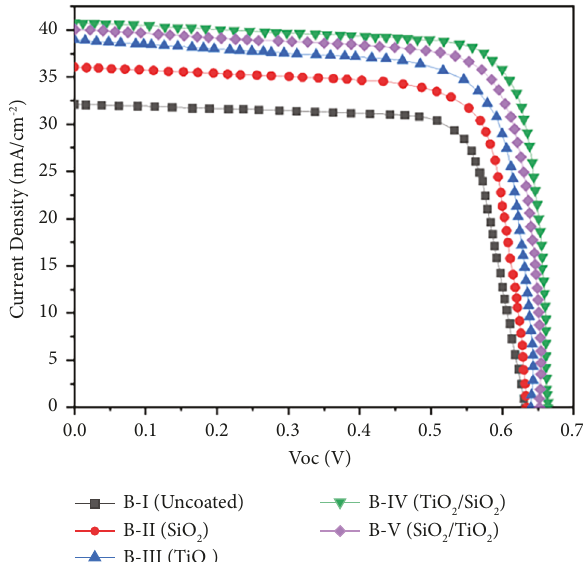
Figure 8: Measured values of the samples under a controlled